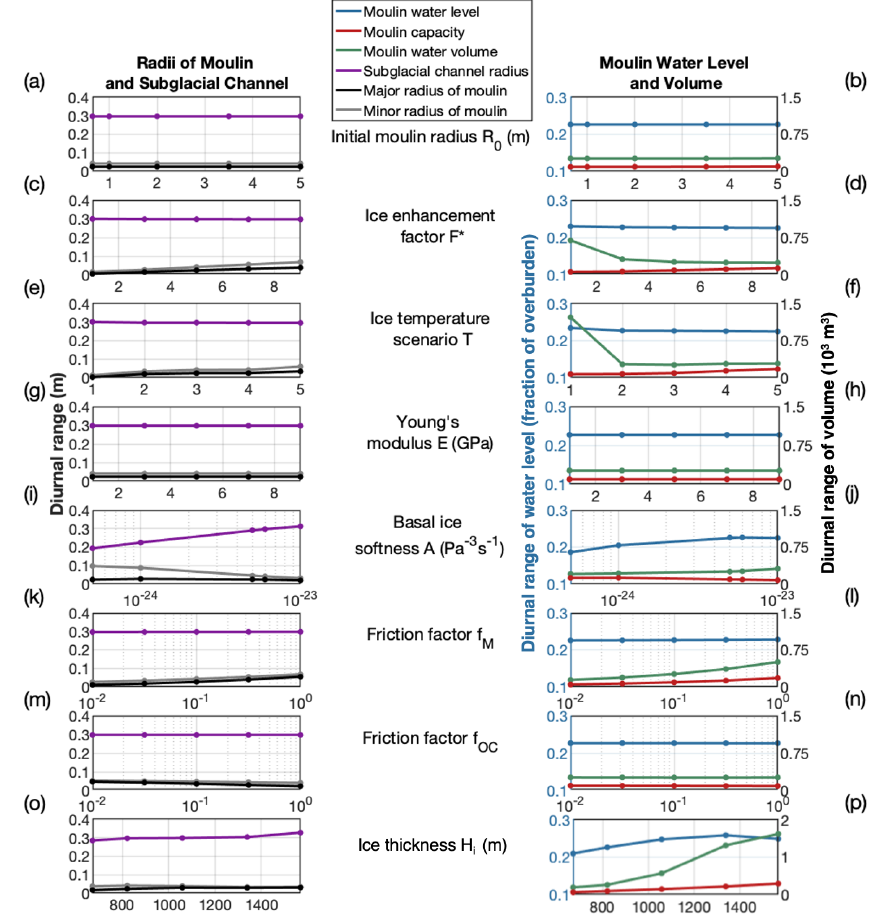
Figure 4. Diurnal variations in moulin sizes in 40d parameter sensitivity runs. Shown are the sensitivity of diurnal variation in moulin size and water storage metrics to initial condition for moulin radius (a, b) , enhancement factor for englacial ice (c, d) , ice temperature scenario from coldest to warmest ice (e, f) , Young’s modulus (g, h) , softness of basal ice (i, j) , friction factor for water flow beneath the water line (k, l) , friction factor for water flow above the water line (m, n) , and ice thickness (o, p) . The left column shows diurnal variations in moulin radii (black and grey) at the equilibrium water level and the subglacial channel radius (purple) in the final 24h period of the 40d model run. The right column shows the diurnal variation in water level (blue), moulin capacity (red), and volume of water in the moulin (green) within the same 24h period. Note the right y -axis difference in panel (p)